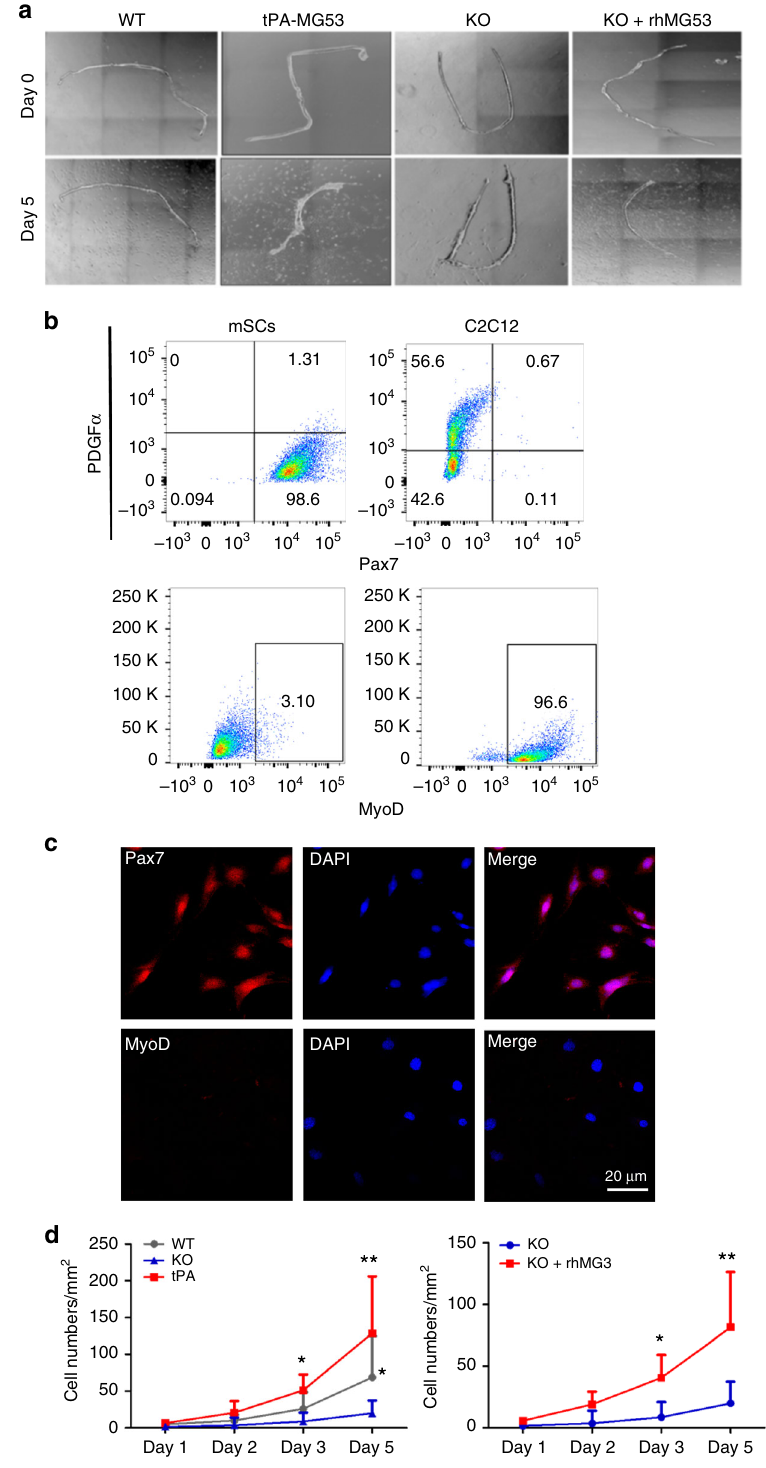
Fig. 6 MG53 modulates muscle satellite cell (mSC) proliferation to contribute to muscle regeneration. a Outgrowth of mSCs from isolated EDL muscle fi bers derived from adult wild-type, tPA-MG53 and KO mice. At day 5 after culture, there were fewer mSCs growing out from KO muscle fi bers, as compared to those from wild type and tPA-MG53 muscle fi bers. Incubation with exogenous rhMG53 (20 μ g/ml) led to increased number of mSCs near the KO myo fi ber (KO + rhMG53). b Flow cytometry analysis with different cell lineage antibodies (Pax7 for mSCs, MyoD for myoblasts, and PDGF α for fi broblasts) to validate the identity of the cultured mSCs. c Immuno fl uorescent staining con fi rmed the high purity of muscle- fi ber derived mSCs, as they are positive for Pax7 and negative for MyoD. d Statistical analysis demonstrate that the compromised proliferation of mSCs derived from KO muscle could be restored by incubation with rhMG53 ( n = 3 – 6 per condition, * p < 0.05 ** p < 0.01 as compared to mg53 − / − fi bers). Error bar represents the standard deviation and p value was generated by t